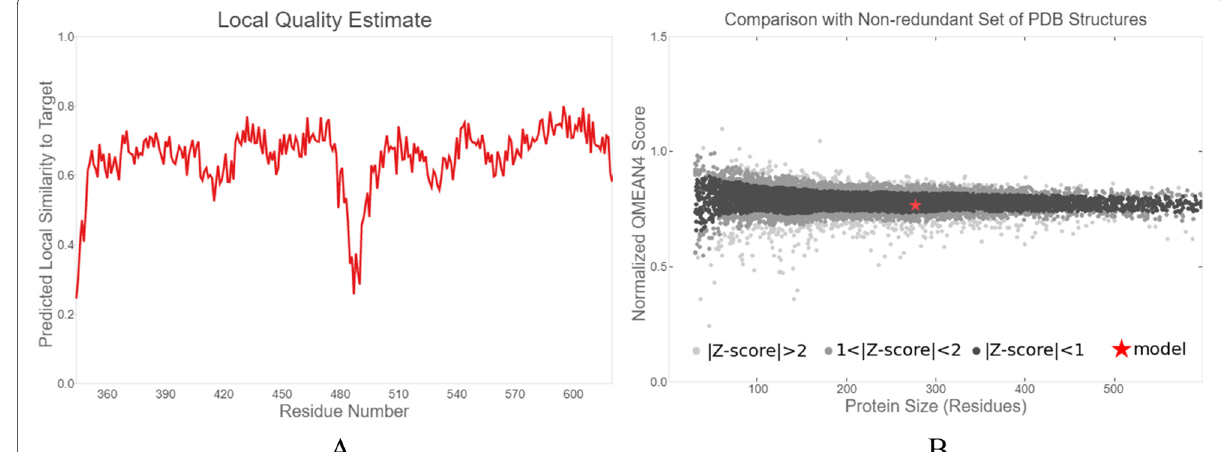
Fig. 2 Further evaluation of the selection model. A Local quality estimate of the predicted model, the figure shows each residue of the model (x‑axis) and the expected similarity to the native structure (y‑axis). B Comparison of model quality scores of individual models to the scores obtained from experimental structures of similar size; the x‑axis is protein length, the y‑axis is the normalized QMEAN score, and every dot represents one experimental